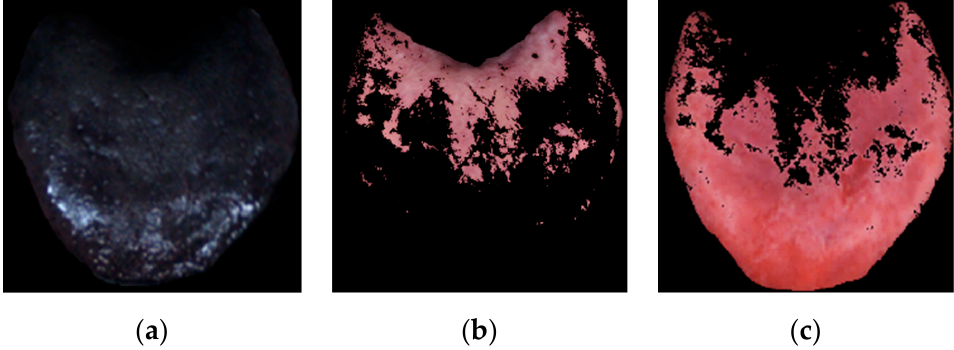
Figure 2. Separation of the tongue into three components: ( a ) glossy image, ( b ) tongue coating, and ( c ) tongue body. Table 2. Total (27) features obtained from each separated image. From Glossy Image From Tongue Coating From Tongue Body